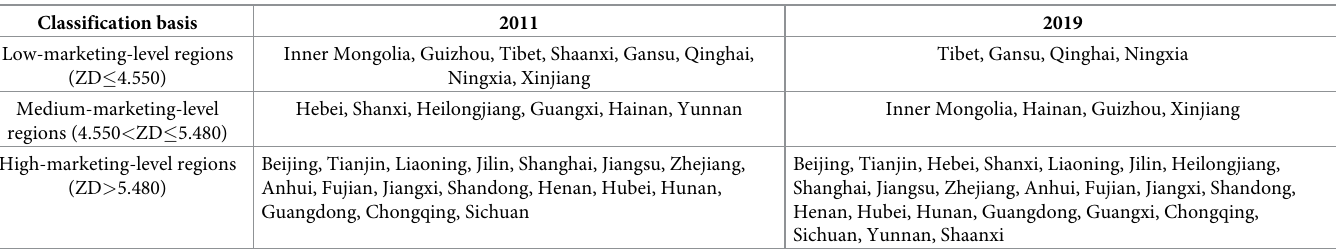
Table 9. Regional distribution pattern of the level of marketization of provincial administrative units in 2011 and 2019. Classification basis 2011 Low-marketing-level regions (ZD � 4.550) Medium-marketing-level regions (4.550 < ZD �